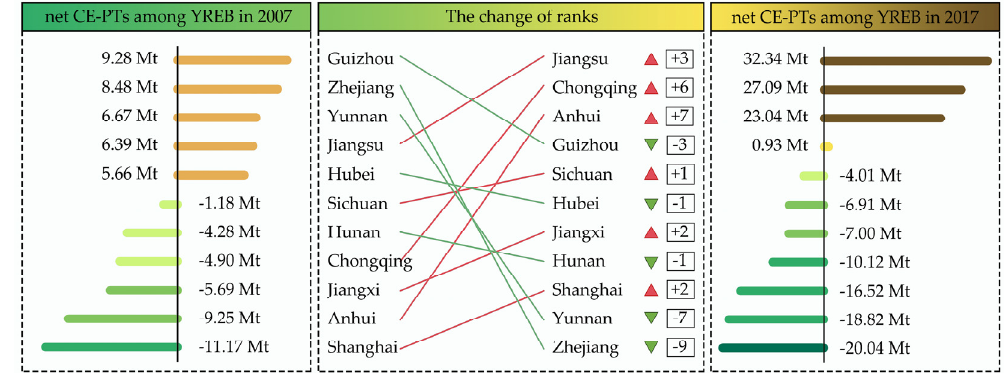
Figure 3. The amount of net ECEs − IPT among the YREB in 2007 and 2017.